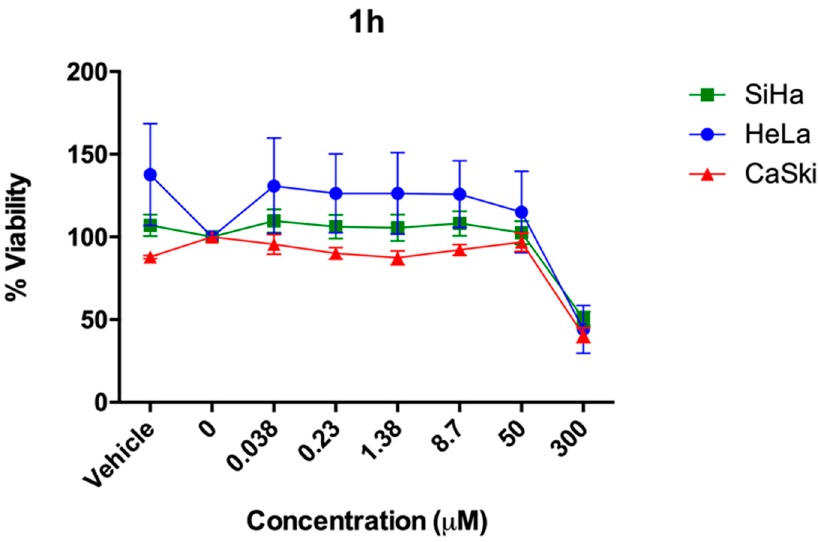
Figure 2. Cell viability of 1h on human cervical cancer cells SiHa, HeLa, and CaSki.